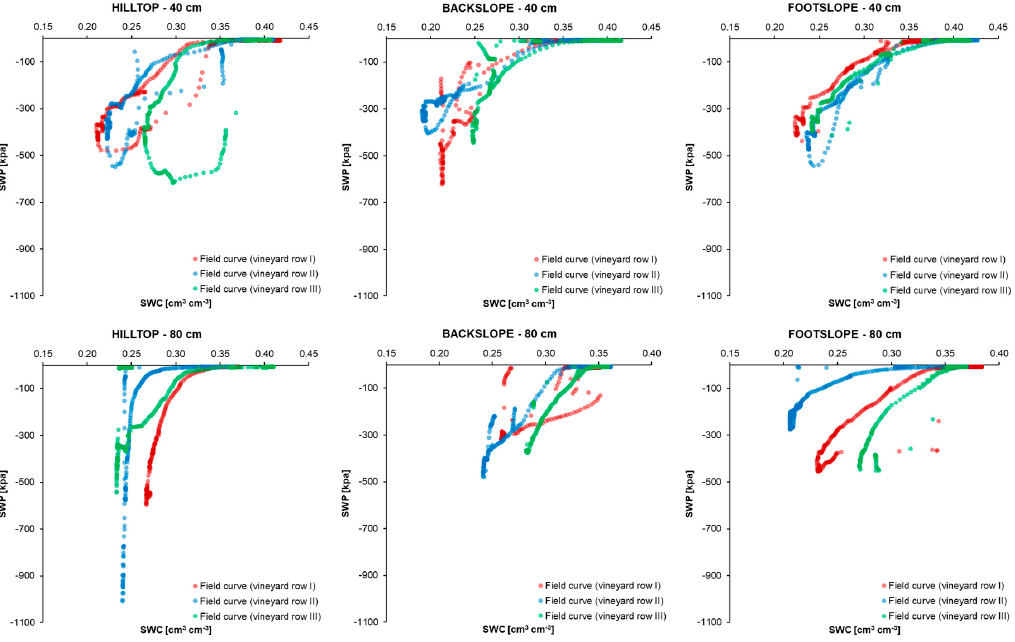
Figure 4. Measured soil water content (SWC) [cm 3 cm − 3 ] and soil water potential (SWP) (daily data) at two depths (40 and 80 cm) in three repetitions (vineyard rows) in 2021 at the SUPREHILL CZO.